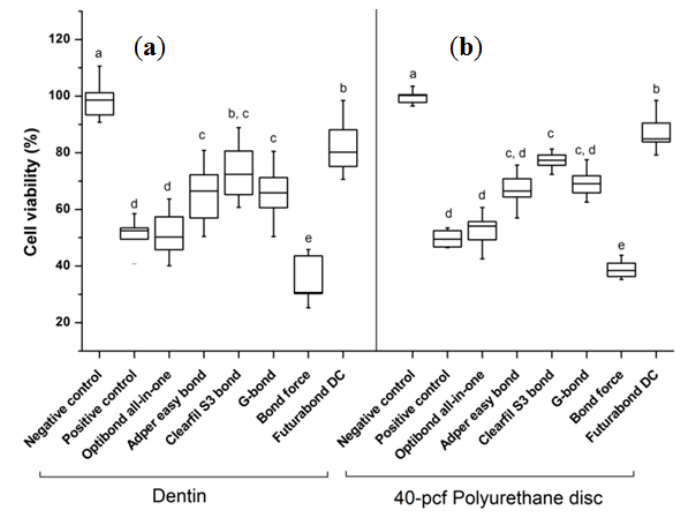
Figure 2. Cell viabilities of different self-etch adhesives using bovine dentin or 40-pcf polyurethane disc as a barrier. This figure shows the cytotoxicity test of different self-etch adhesives by ( a ) bovine dentin; or ( b ) 40-pcf polyurethane disc. Each box in the boxplot graph means the maximum, 75%; median, 25%; and minimum values. Among adhesives, Futurabond DC showed the highest cell viability, and Bond force did the lowest one ( P < 0.05) regardless of the barrier type. The gap of standard deviations by 40-pcf polyurethane disc was less than that by natural bovine dentin in all groups. Groups with different letters above the data bar are statistically significant ( P <